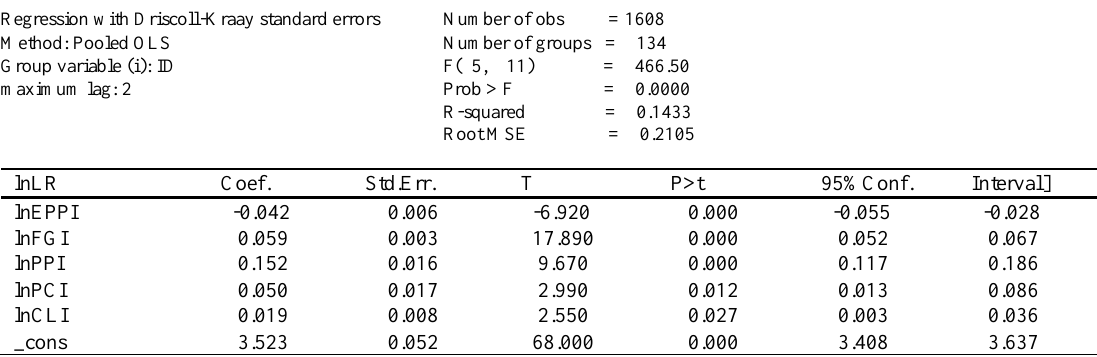
Table 4: Driscoll-Kraay pooled OLS model